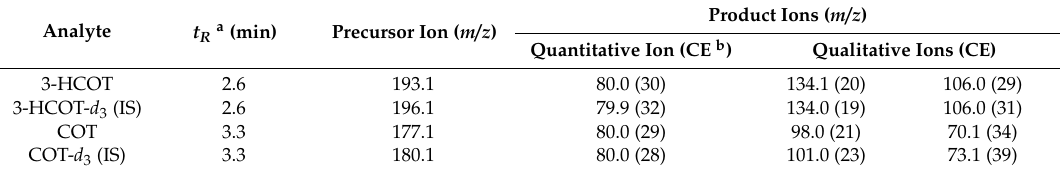
Table 5. MRM transitions and collision energies for target analytes and internal